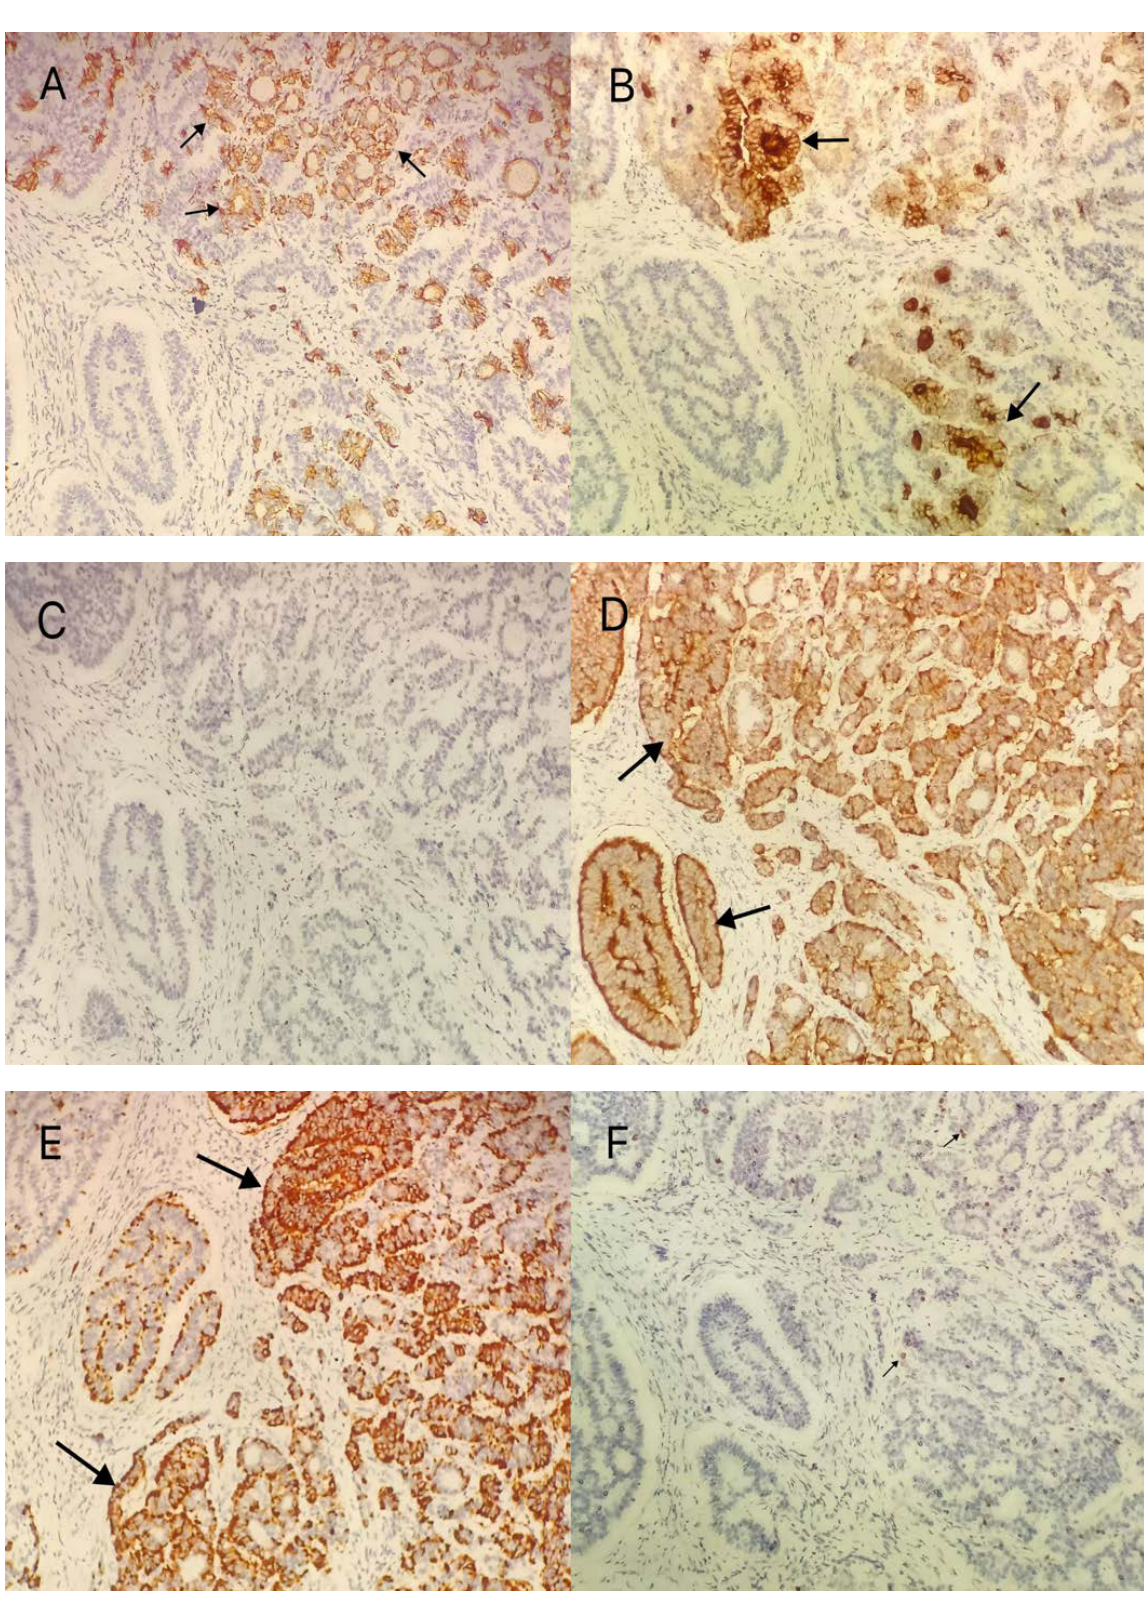
Figure 4. Immunohistochemically tumor cells were positive for: ( A ): CK7 (+), IHC × 200; ( B ): Tg (+), IHC × 200, ( C ): CK20 ( − ) IHC × 200; ( D ): Syn (++), IHC × 200; ( E ): GgA (++); IHC × 200; ( F ): Ki-67 (5%+) IHC × 200. (The black arrow indicates the site of the tumor with positive